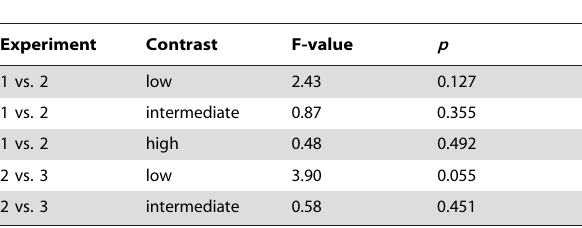
Table 3. Results from individual contrasts by experiment (e.g., Expt 1 ‘low’ treatment contrasted with Expt 2 ‘low’ treatment) of prey survivorship between